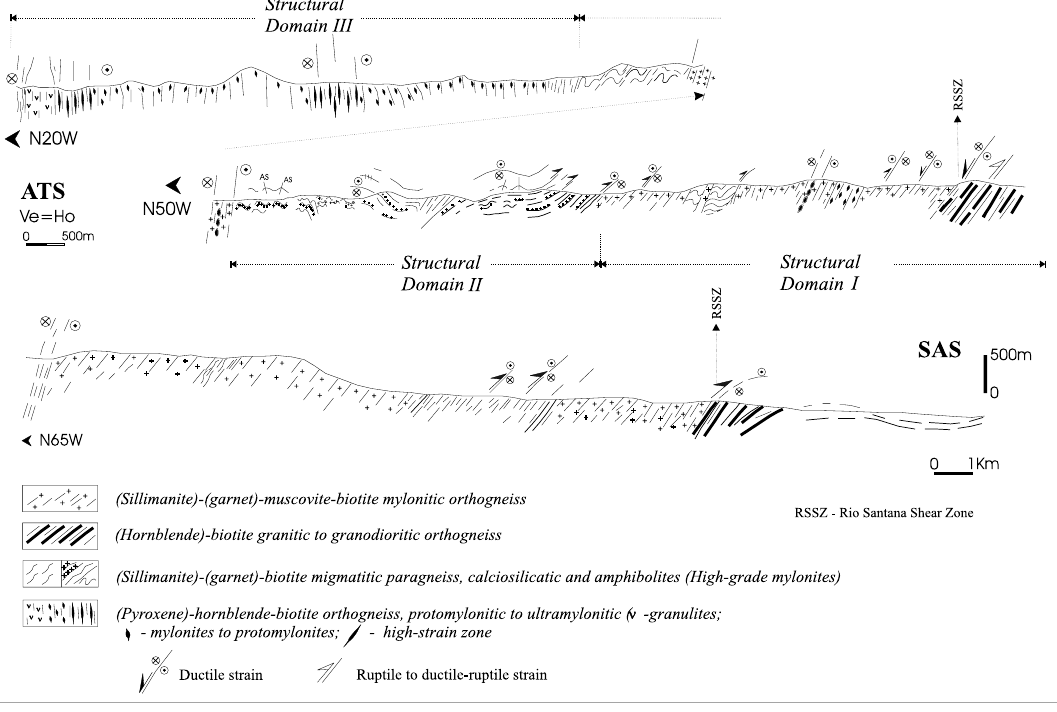
Fig. 2 – Lithostructural cross-sections studied in this paper. ATS – Areal-Três Rios section; SAS – Serra das Araras section. Stereographic plots shown in figure 3 follow the structural domains and major structures defined in the